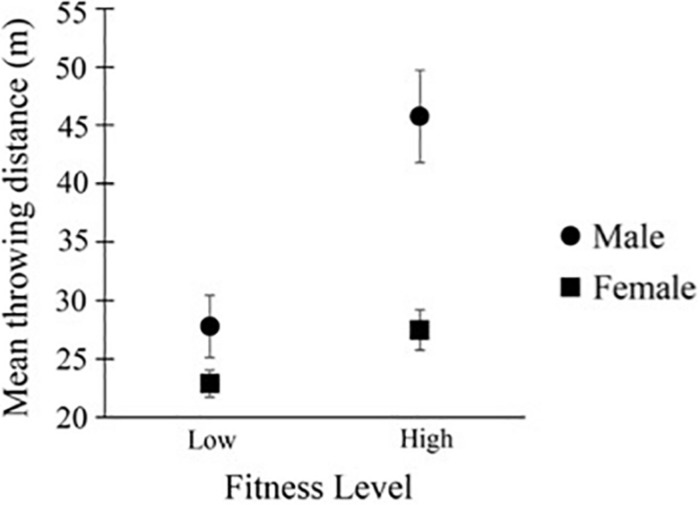
Throwing performance of the four selected confederates. On the y-axis was the mean throwing distances of the most throwable balls of all size groups. Error bars = 1 SE.